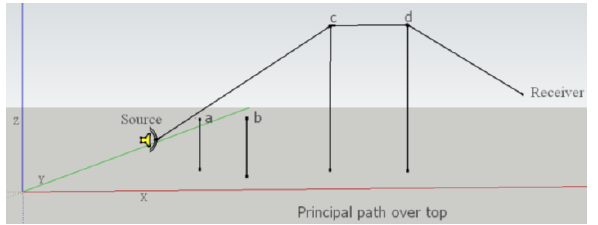
Figure 5. Final diffracting path over top. It is determined from effective diffracting points between source and receiver 3.4 Determination of diffracting path around sides: Similar to the path over top, the paths around sides of building or wall or obstruction are determined using another cutting plane. A plane perpendicular to X-Z plane and passing through and bounded by the source and receiver is considered as cutting plane (Figure 6). The edges of buildings/walls that are intersected by the plane are determined (Figure